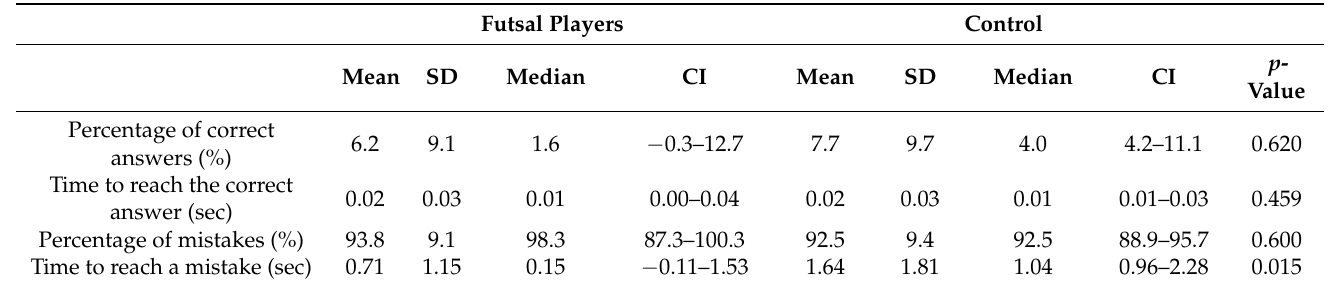
Table 1. Results of Anticipation time test.